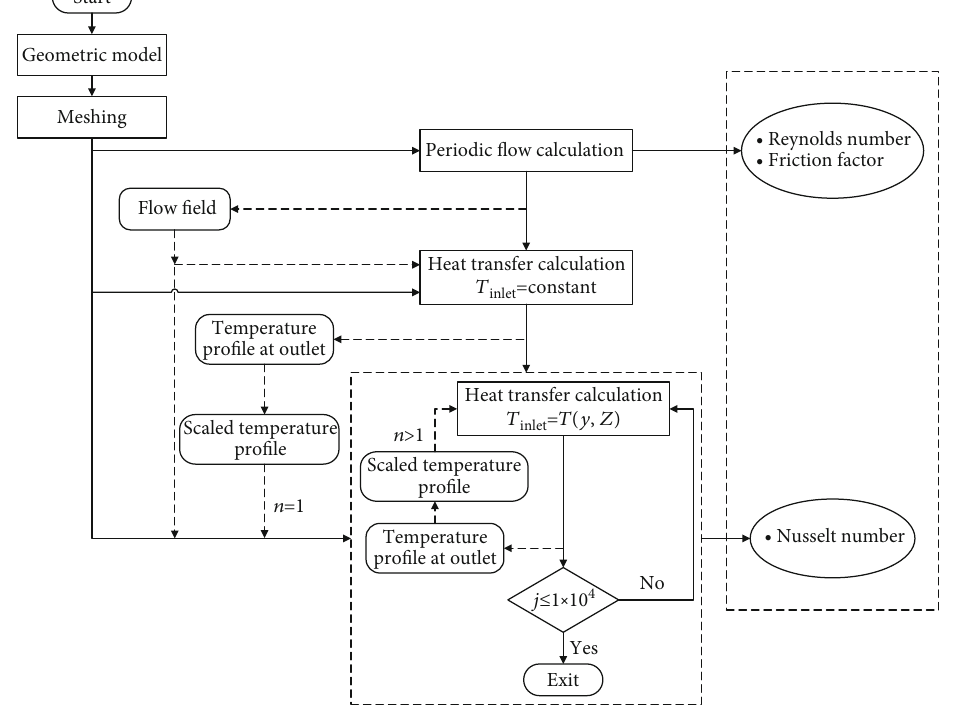
Figure 5: Illustration of the analysis procedure.